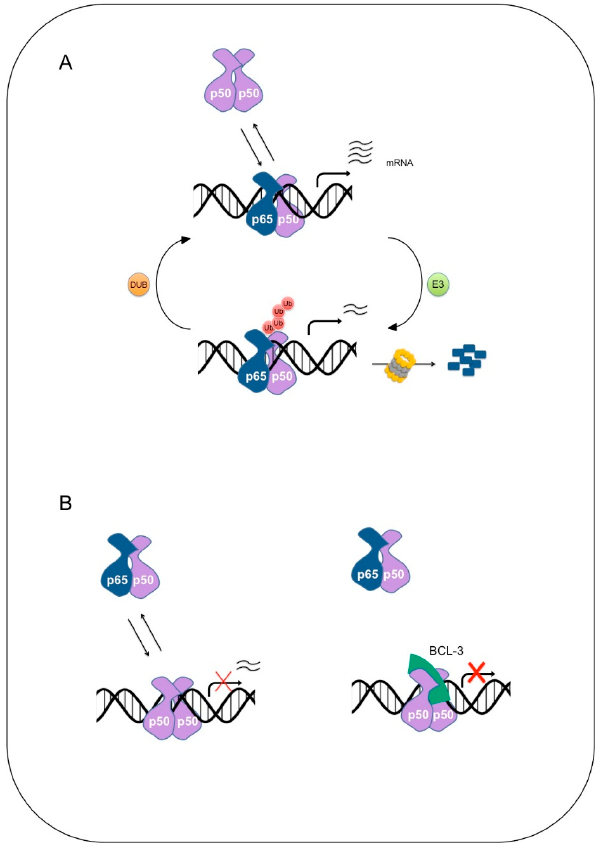
Figure 2. Regulation of NF- κ B dependent transcription by ubiquitination. ( A ) Once liberated from cytoplasmic retention, NF- κ B dimers are free to translocate to the nucleus and bind κ B sites in the promoter and regulatory regions of NF- κ B responsive genes to activate transcription. Promoter occupancy is highly dynamic and NF- κ B dimers are in constant competition for binding at these sites. DNA binding triggers the ubiquitination and subsequent degradation of promoter-bound NF- κ B allowing the promoter to be reloaded by another NF- κ B dimer. Deubiquitases (DUB) oppose the action of the E3 ubiquitin ligase, removing the degradative signal and in turn extending the occupancy time of the dimer; ( B ) many NF- κ B dimers can bind to the same κ B sites. As p50 does not contain a transactivation domain, binding of p50 homodimers to κ B sites represses the transcription of NF- κ B dependent genes. As with p65, DNA binding triggers the ubiquitination of p50 however this can be inhibited by the nuclear I κ B protein, BCL-3, extending the occupancy time of inhibitory p50